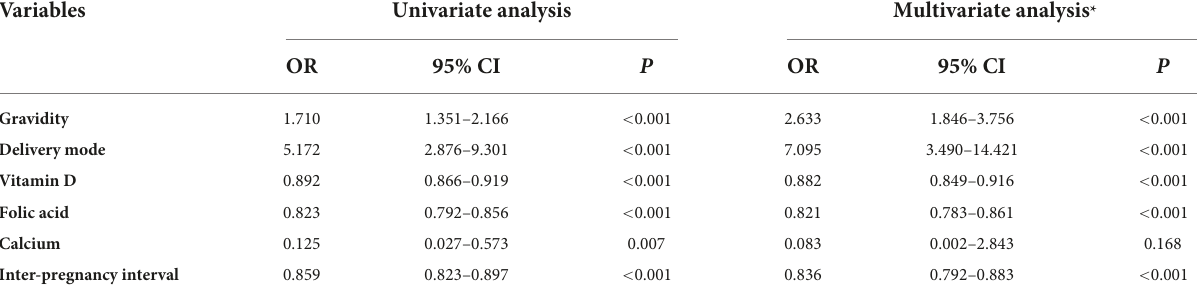
TABLE 2 The univariate and multivariate analysis for risk factors associated with depression during